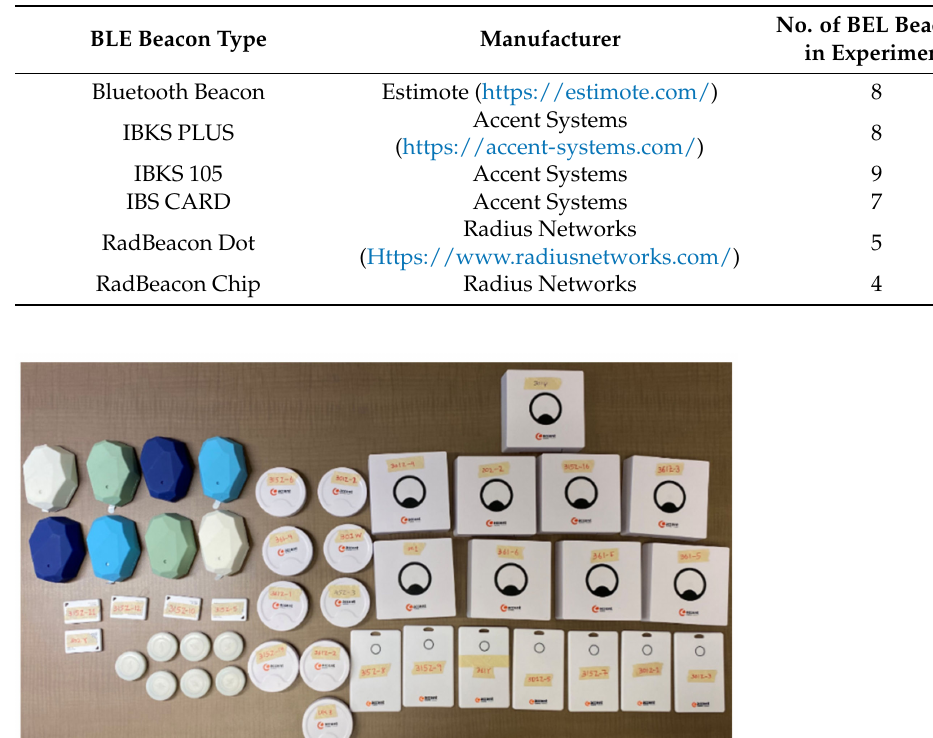
Table 3. Details of BLE beacons used in real-world experiment.